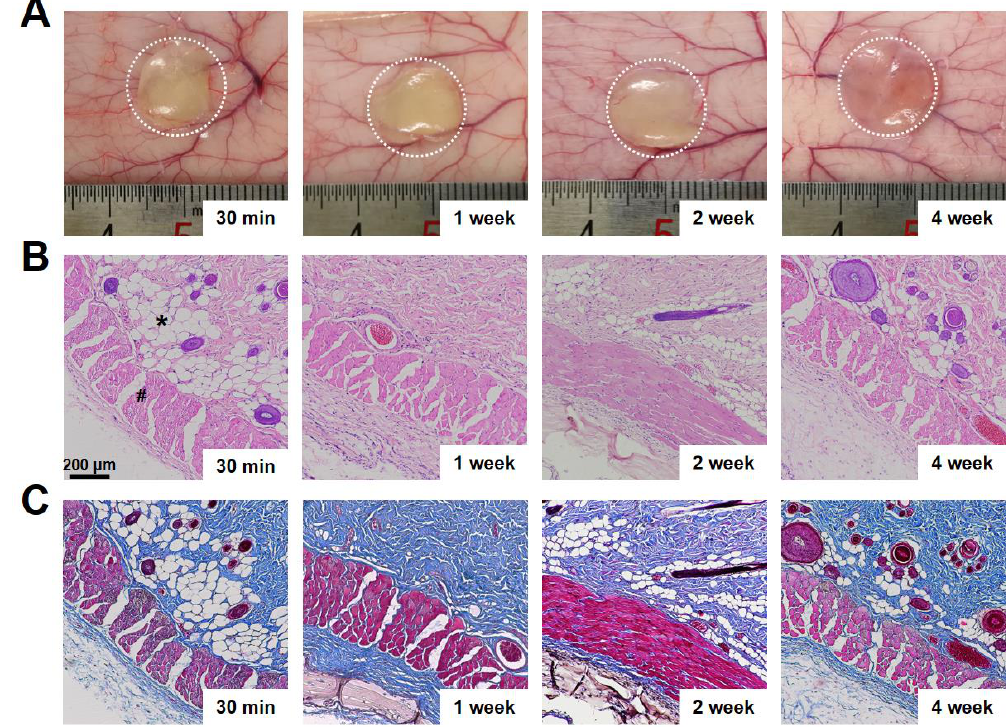
Figure 5. In vivo biocompatibility of click polypeptide hydrogels. ( A ) Representative images of hydrogels following subcutaneous injection into rats at different time intervals. ( B ) H&E staining, and ( C ) Masson’s trichrome staining of the hydrogels and the surrounding tissues at corresponding time intervals. The asterisks indicate the location of the hydrogels.